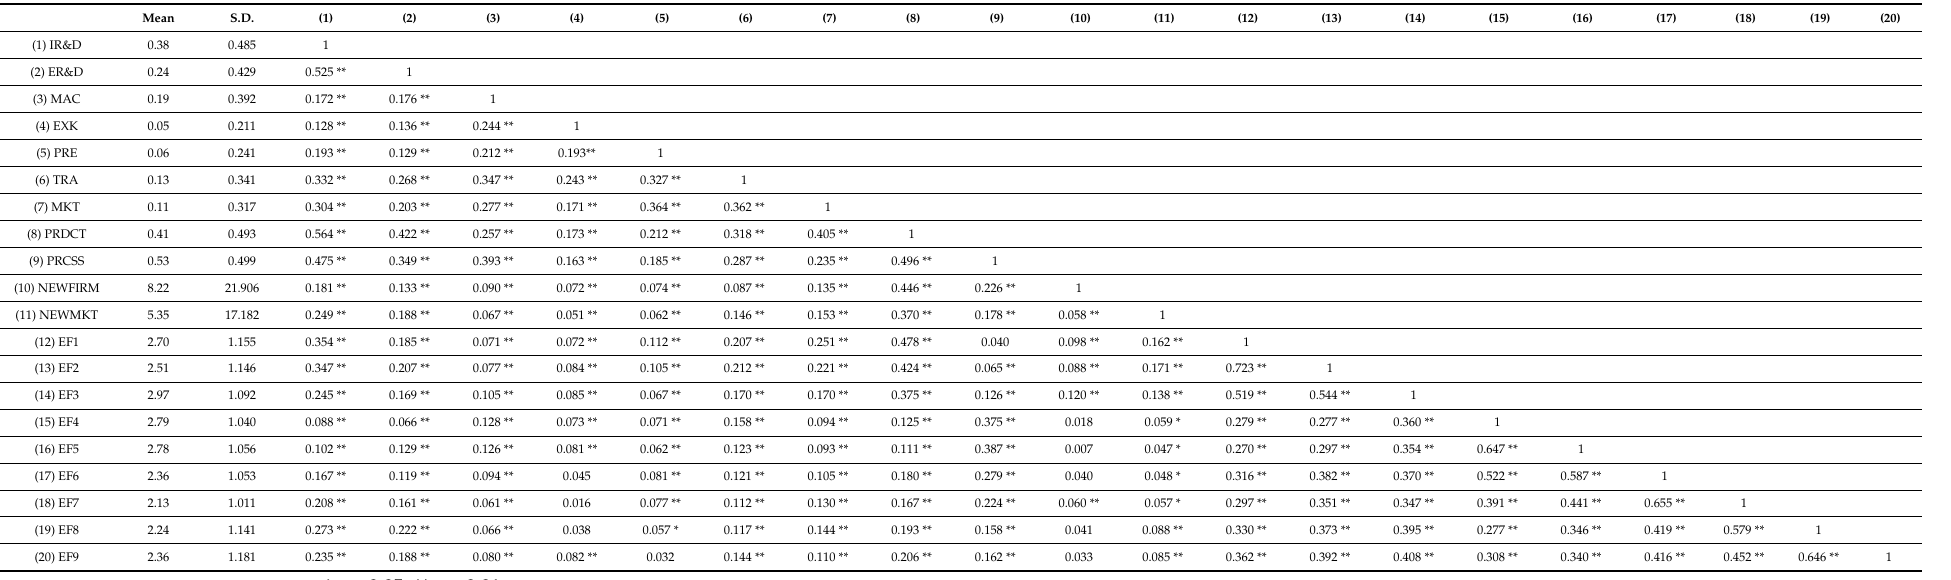
Table 5. Means, standard deviations and correlation